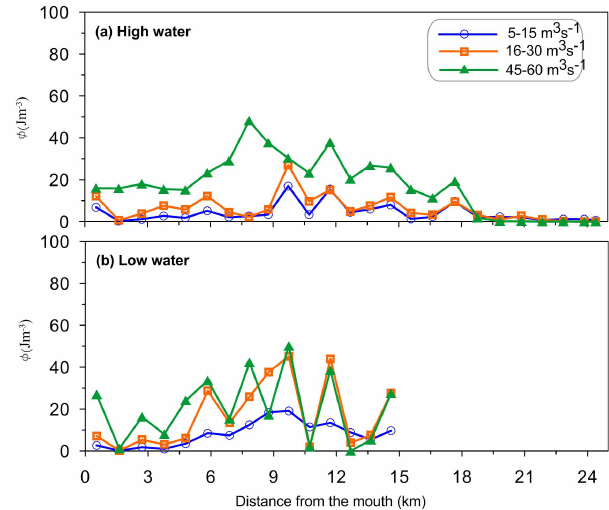
Fig. 7. Spatial variation in the potential energy anomaly at low and high tides along the Sumjin River Estuary under different river discharges.